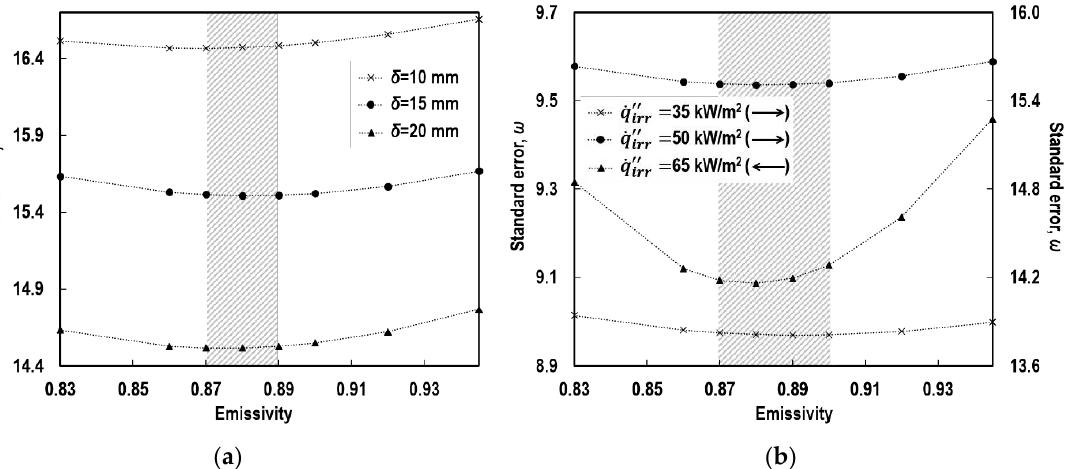
Figure 9. Variations in standard error according to the alteration of emissivity at ( a ) 𝑞̇ 𝑖𝑟𝑟′′ = 50 kW/m 2 and ( b ) δ = 15 mm.